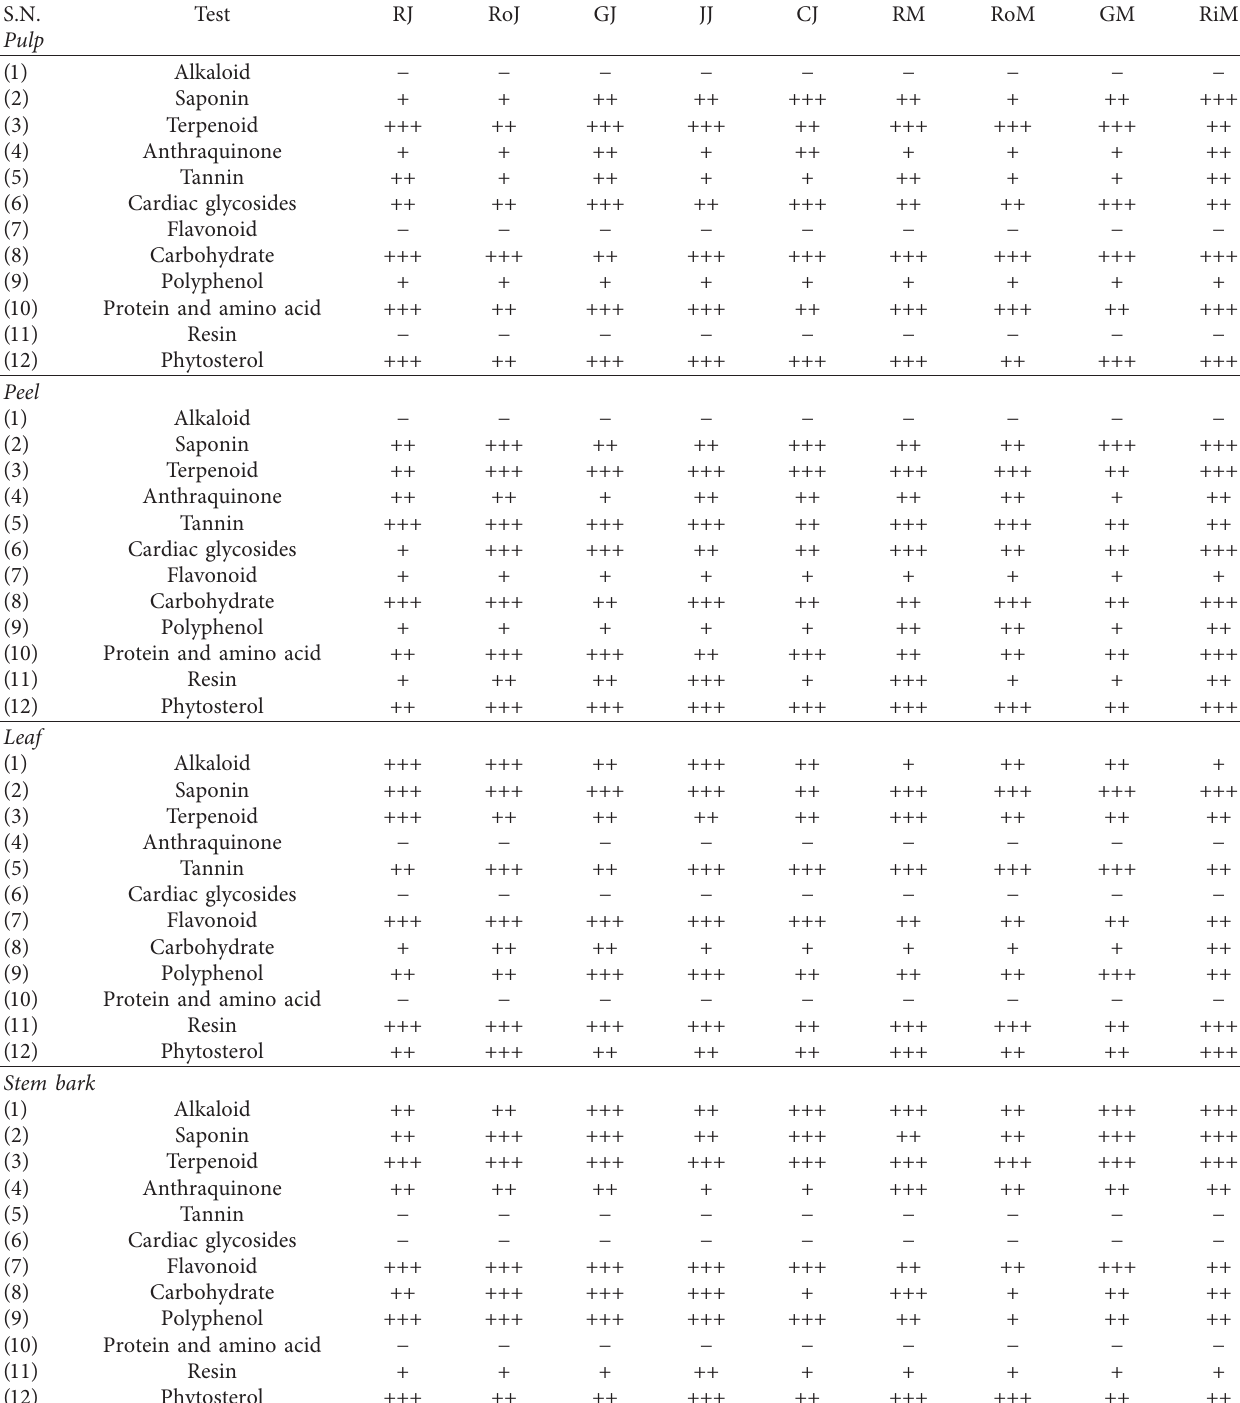
Table 2: Phytochemical screening of pulp, peel, leaf, and stem bark of different M. domestica cultivars from two regions of Nepal.